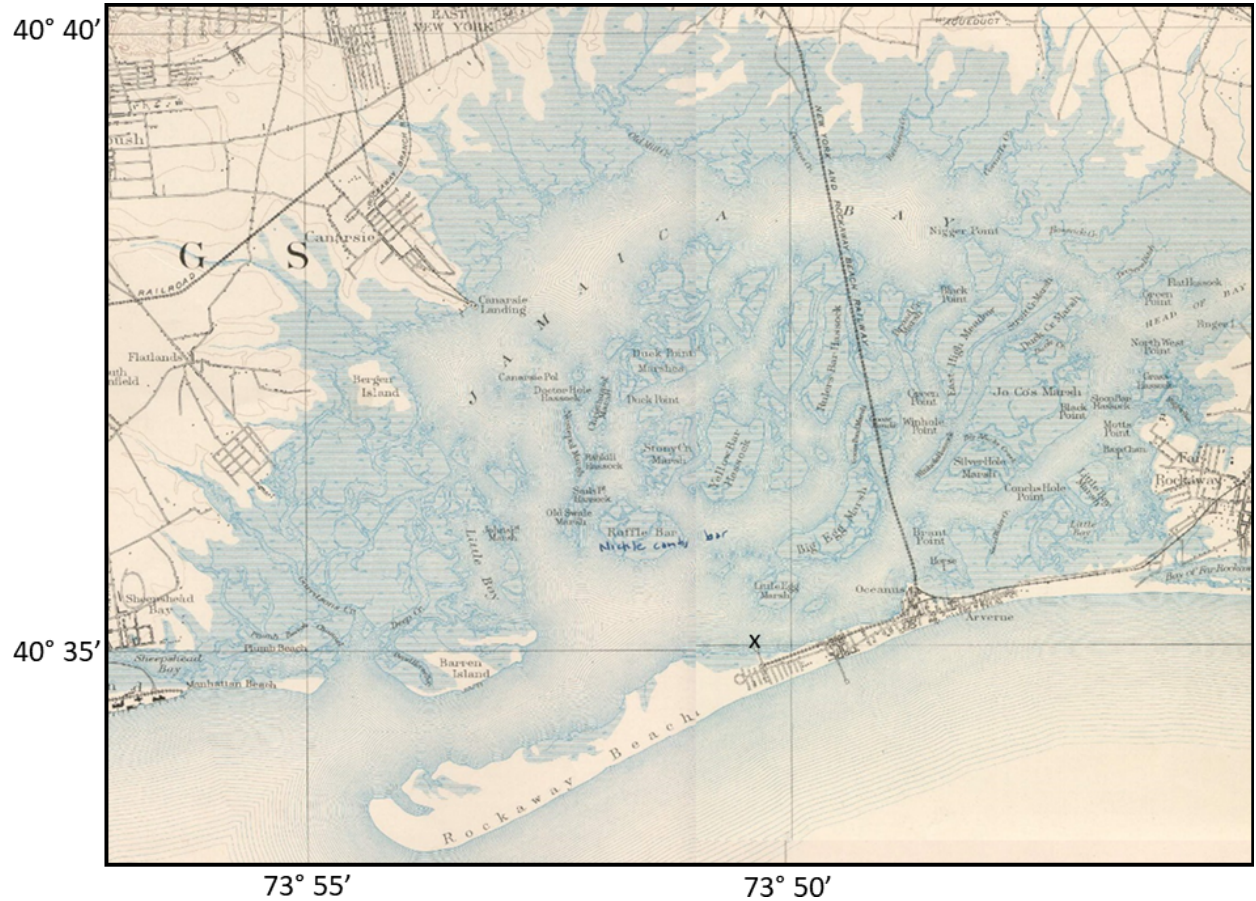
Figure 1. An 1888-1889 survey map of Jamaica Bay, in southeast New York City, portraying the morphology and marsh cover (blue hatching). The map is excerpted from Powell (1891), and the “x” marks the Holland House pier tide measurement